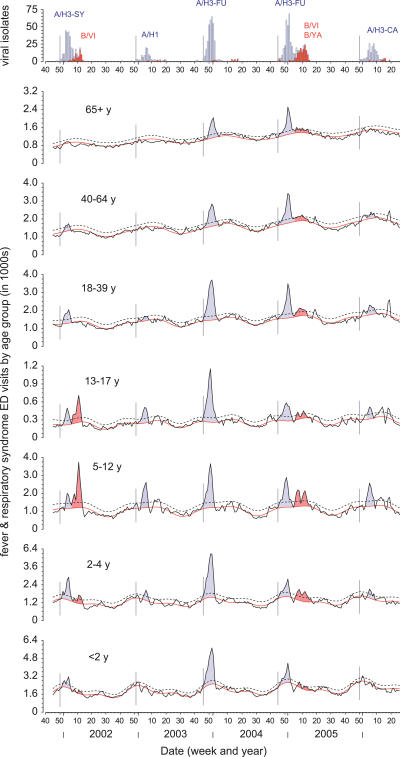
Weekly Age-Specific Fever and Respiratory ED Visits in New York City during the 2001–2002 to 2005–2006 SeasonsObserved fever and respiratory ED visits by age group are shown as black lines, and seasonally expected Serfling baseline visits are as red lines. Dashed lines represent model estimates plus two standard deviations. Shaded areas represent influenza-attributable excess ED visits by type A (blue) or B (red). Vertical lines indicate the first week of continuous influenza isolate reporting. Codes in top graph: A/H3-SY, influenza A(H3N2) Sydney; B/VI, influenza B/Victoria; A/H1, either A(H1N1) New Caledonia or A(H1N2) Wisconsin; A/H3-FU, influenza A(H3N2) Fujian; B/YA, influenza B/Yamagata; and A/H3-CA, influenza A(H3N2) California.